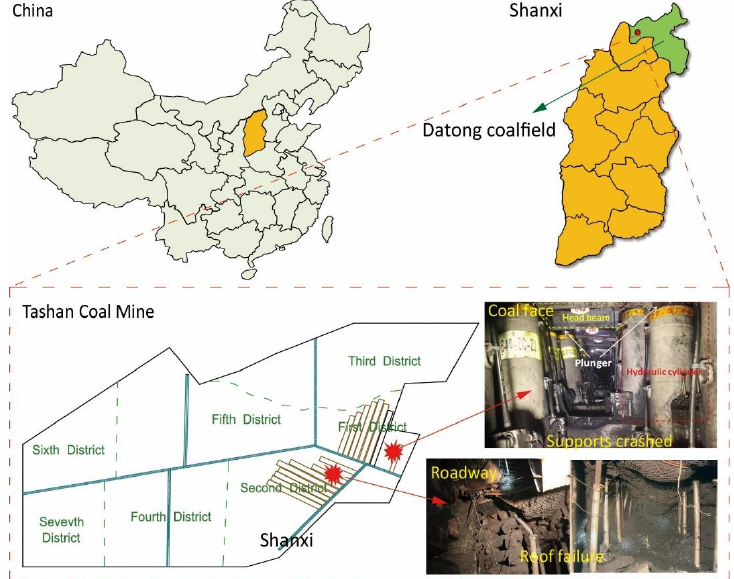
Figure 1. Location of Tashan Coal Mine.